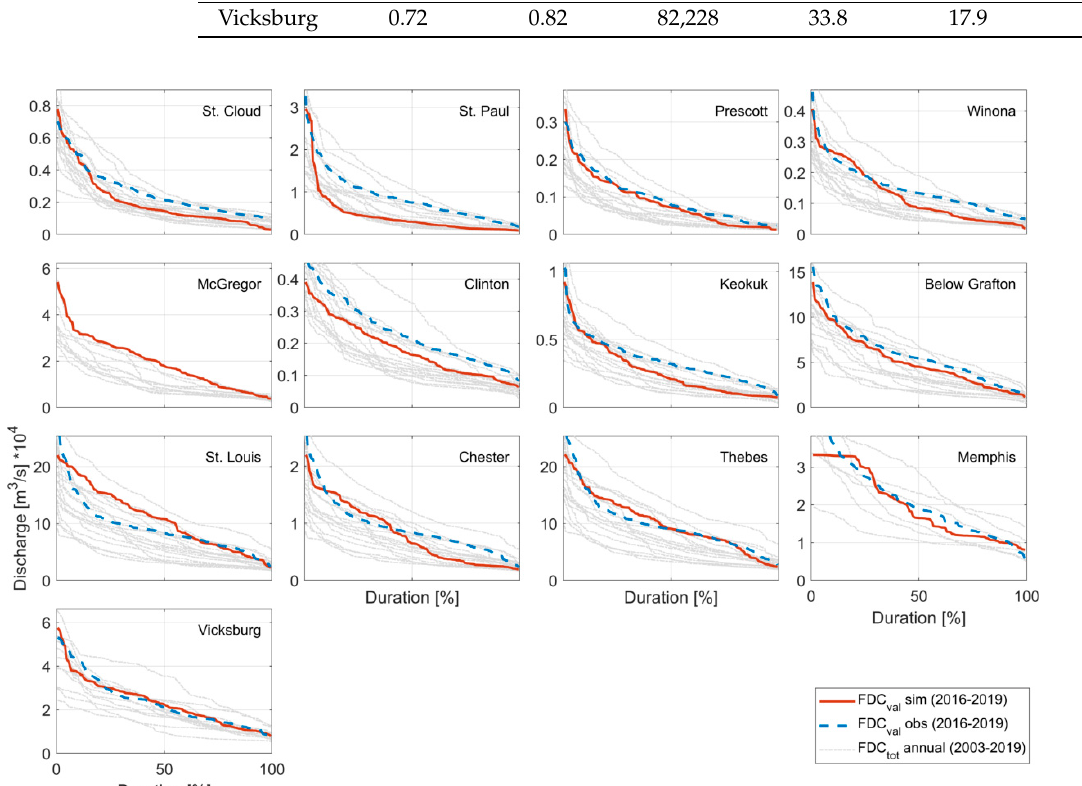
Figure 8. Simulated and observed FDCs for the period of validation (2016–2019). For comparison, the FDC built on single years of the entire observation period, 2003–2019, are also represented.